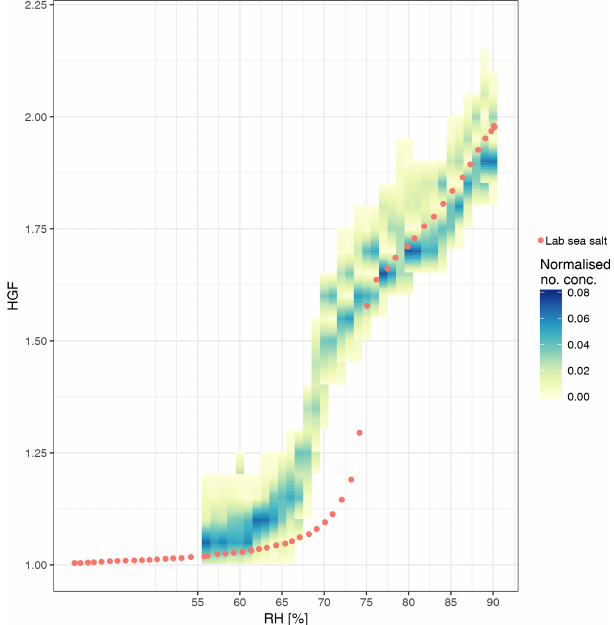
Figure 10. Deliquescence of 50nm SSA generated from the SOAP seawater sample (Workboat 9) shown in yellow to blue colour scale. The laboratory sea salt deliquescence curve is shown with